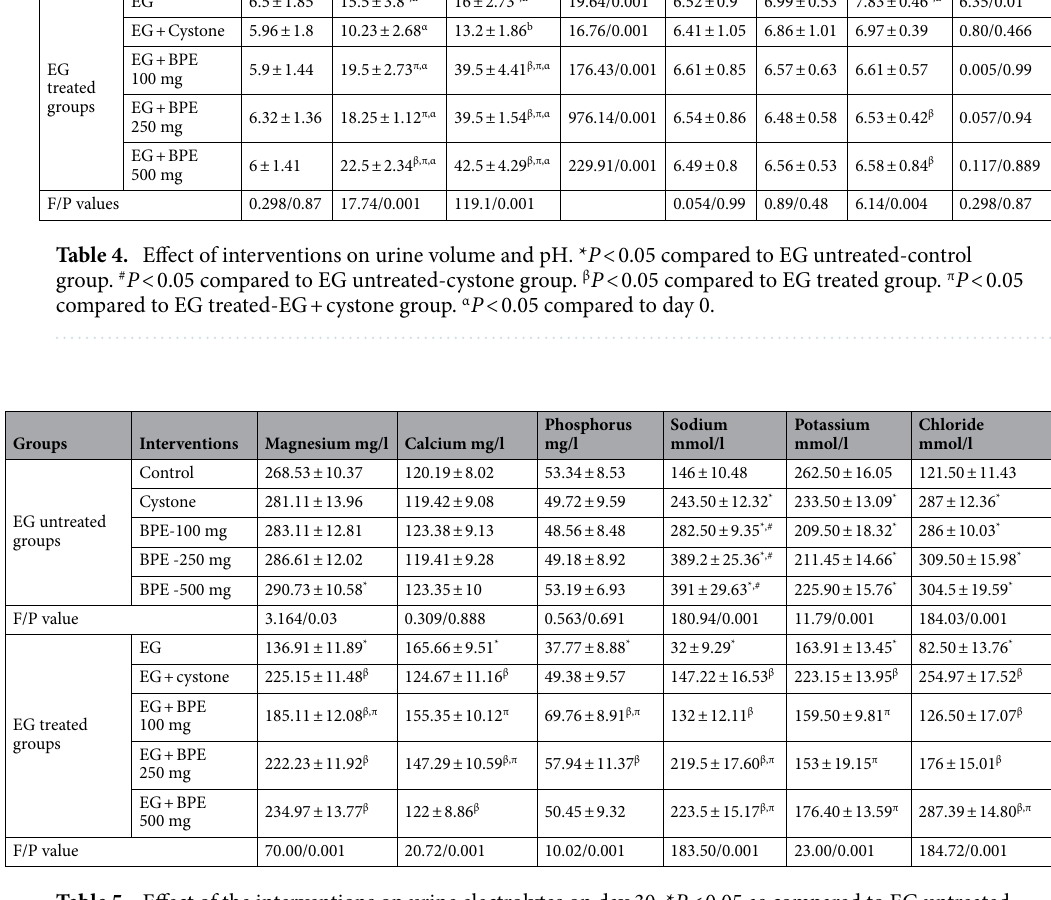
Table 5. Effect of the interventions on urine electrolytes on day 30. * P < 0.05 as compared to EG untreated- control group. # P < 0.05 as compared to EG untreated-cystone group. β P < 0.05 as compared to EG treated group. π P < 0.05 as compared to EG treated-EG + cystone